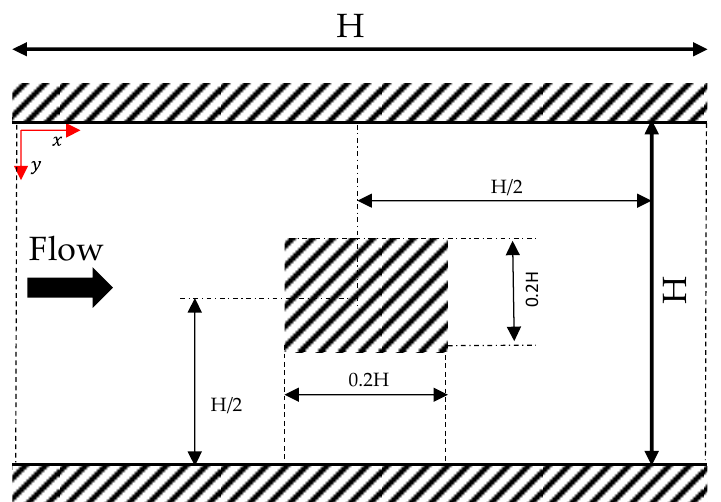
Figure 7. Simulation domain adapted from [43].